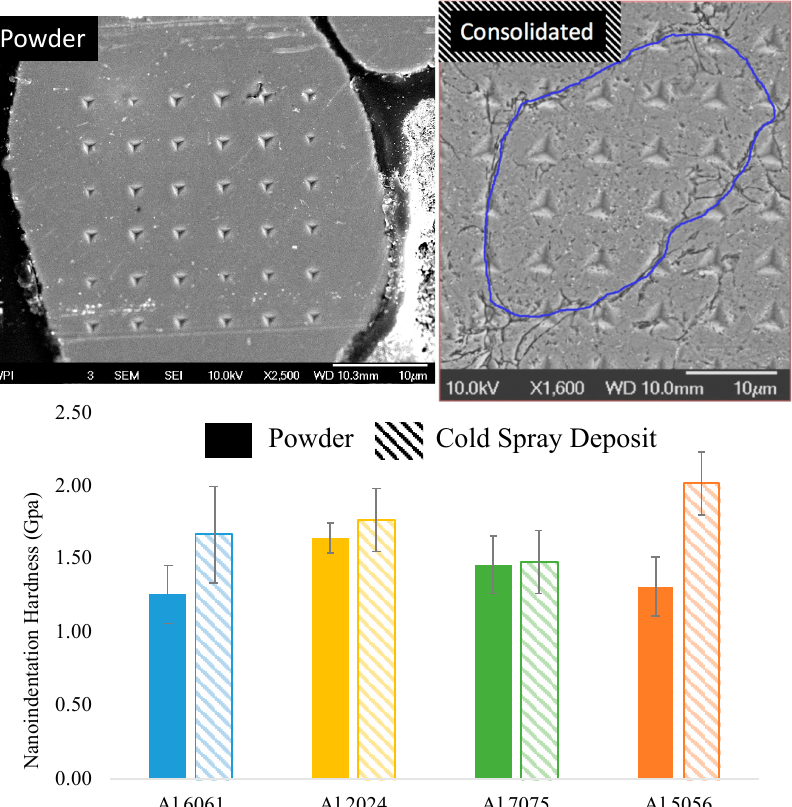
Figure 39. ( Left ) SEM image of a grid of hardness indents on a single Al 6061 powder particle. ( Right ) SEM image of a grid of hardness indents on the spray direction face of a consolidated Al 6061 coating. The coating was etched with 0.5% hydrofluoric acid solution for 5 s to reveal particle boundaries. A blue line highlights one particle boundary. ( Bottom ) depicts a graph of the average hardness for Al 6061, Al 2024, Al 7075 and Al 5056. The average hardness for all sizes of powder is shown by the solid bar, while the dashed bar represents the consolidated sample.